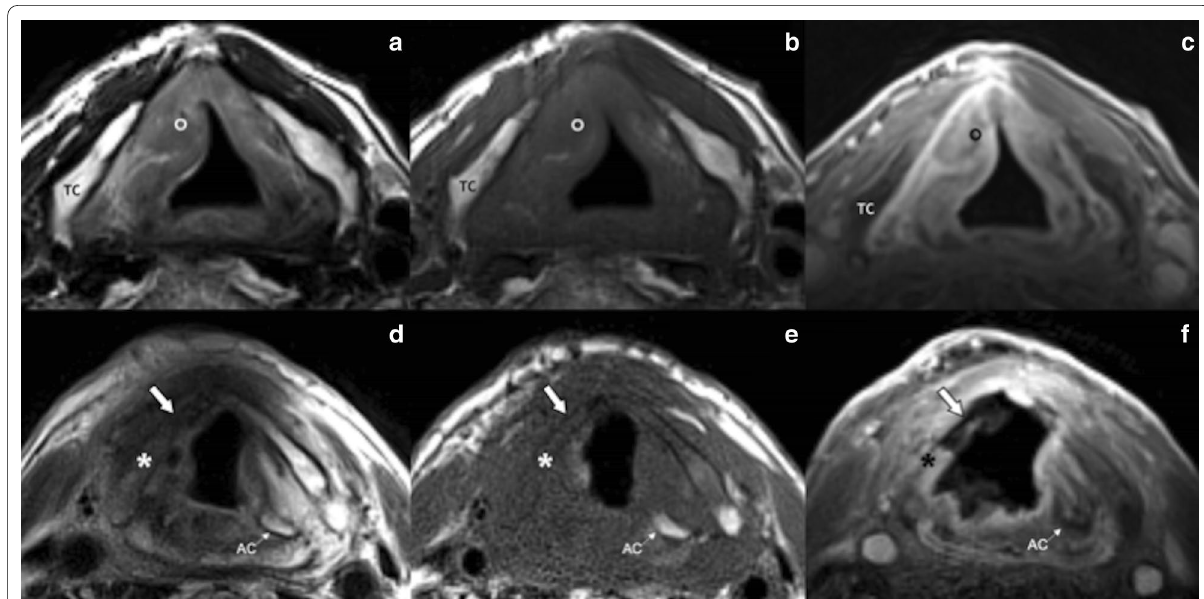
Fig. 11 Laryngeal necrosis in an 88-year-old man five months after RT for a right glottic-supraglottic cancer. Surface-coil MRI of the larynx: pre-treatment axial T2-weighted ( a ), T1-weighted ( b ) and post-contrast 3D GRE fat-sat T1-weighted ( c ) MR images show a lesion of the right vocal fold (circle). Post-treatment axial T2-weighted ( d ), T1-weighted ( e ) and post-contrast 3D GRE fat-sat T1-weighted ( f ) show extensive necrosis of the right true vocal fold, anterior commissure and right lamina of the thyroid cartilage (asterisk); the right arytenoid cartilage is not recognizable. Cartilage fragmentation is pointed by the bold white arrow. TC, thyroid cartilage, AC, arytenoid cartilage